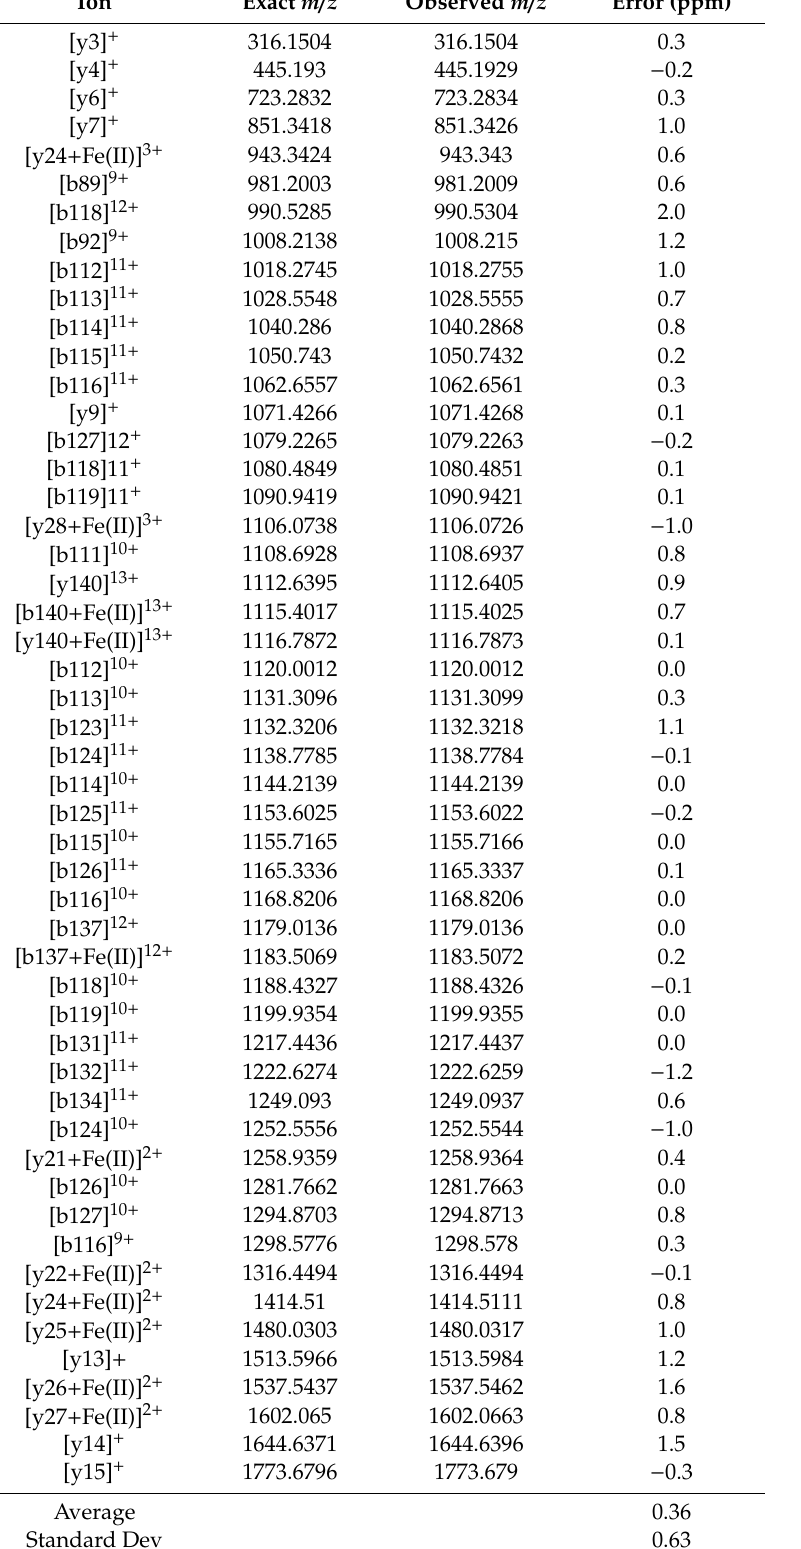
Table A2. Collision-induced dissociation of [ α -syn +